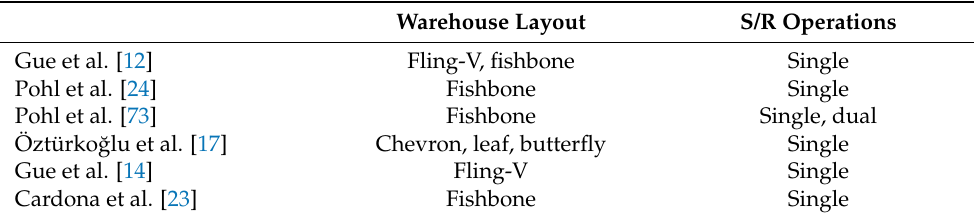
Table 2. The studies of S/R operation strategies in non-traditional layouts. Warehouse